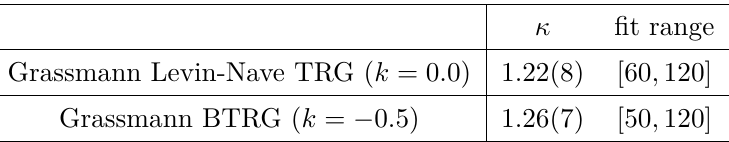
Figure 4 . Relative error of the free energy as a function of the hyperparameter k . Different curves correspond to the results with the various bond dimension D . The relative error is evaluated on the square lattice whose size is 2 20 .